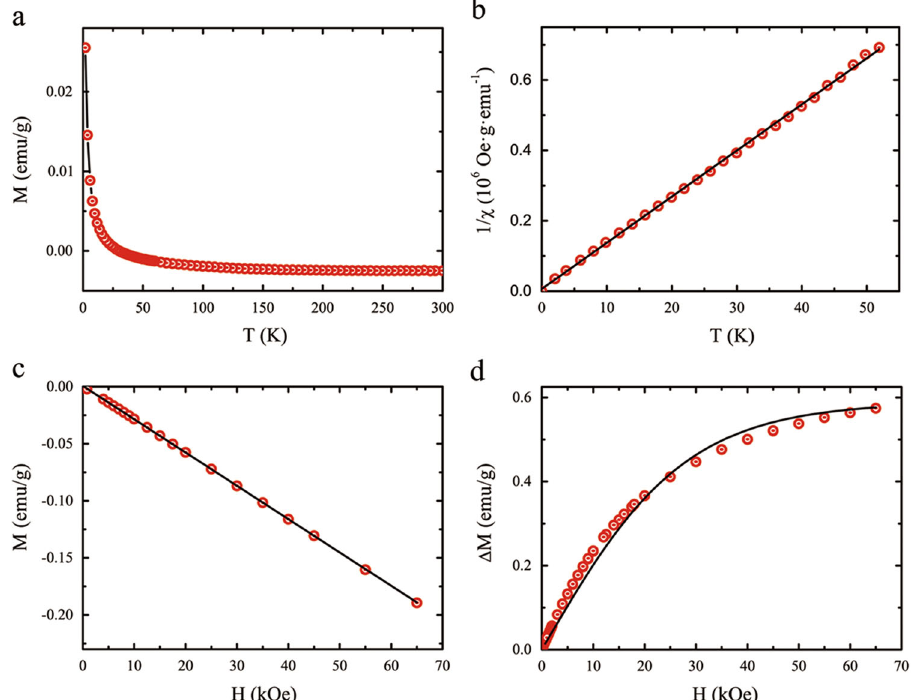
Fig. 4 Magnetic properties of GQDs. a M – T and b 1/ Χ – T under the applied fi eld H = 1 kOe. The round symbols are the measurements and the solid lines are fi tted by the Curie law. c M – H measured at 300 K. d Δ M – H measured at 2 K. The round symbols are the measurements and the solid lines are fi t to Brillouin function. The coef fi cient of determination for the fi tting is 0.9997 indicating the goodness of fi tting